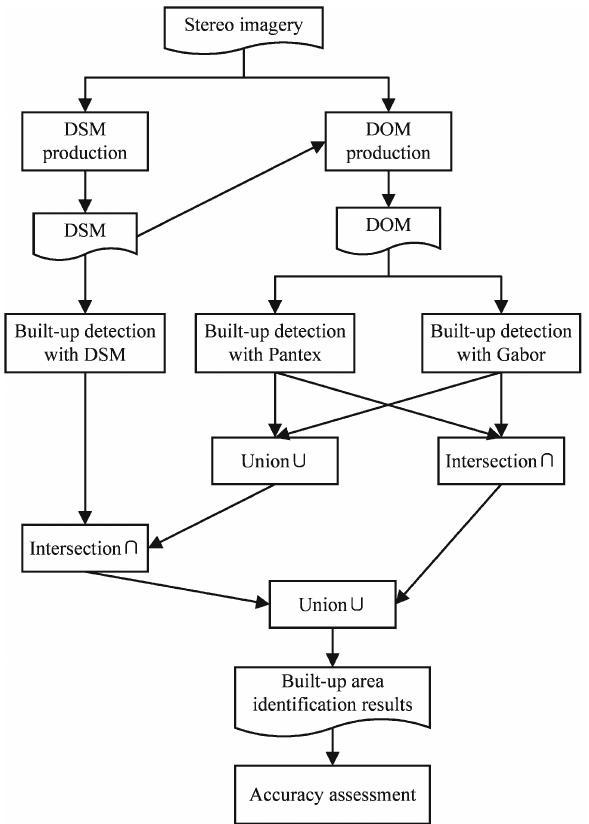
Figure 2. Flowchart of our method to detect built-up areas from stereo imagery.